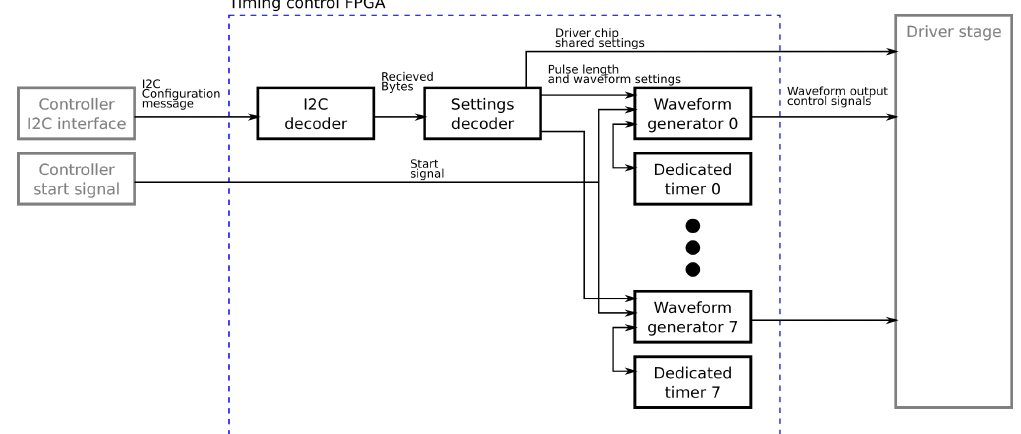
Figure 8. Simplified block diagram of Field Programmable Gate Array (FPGA) logic blocks used to generate pulse